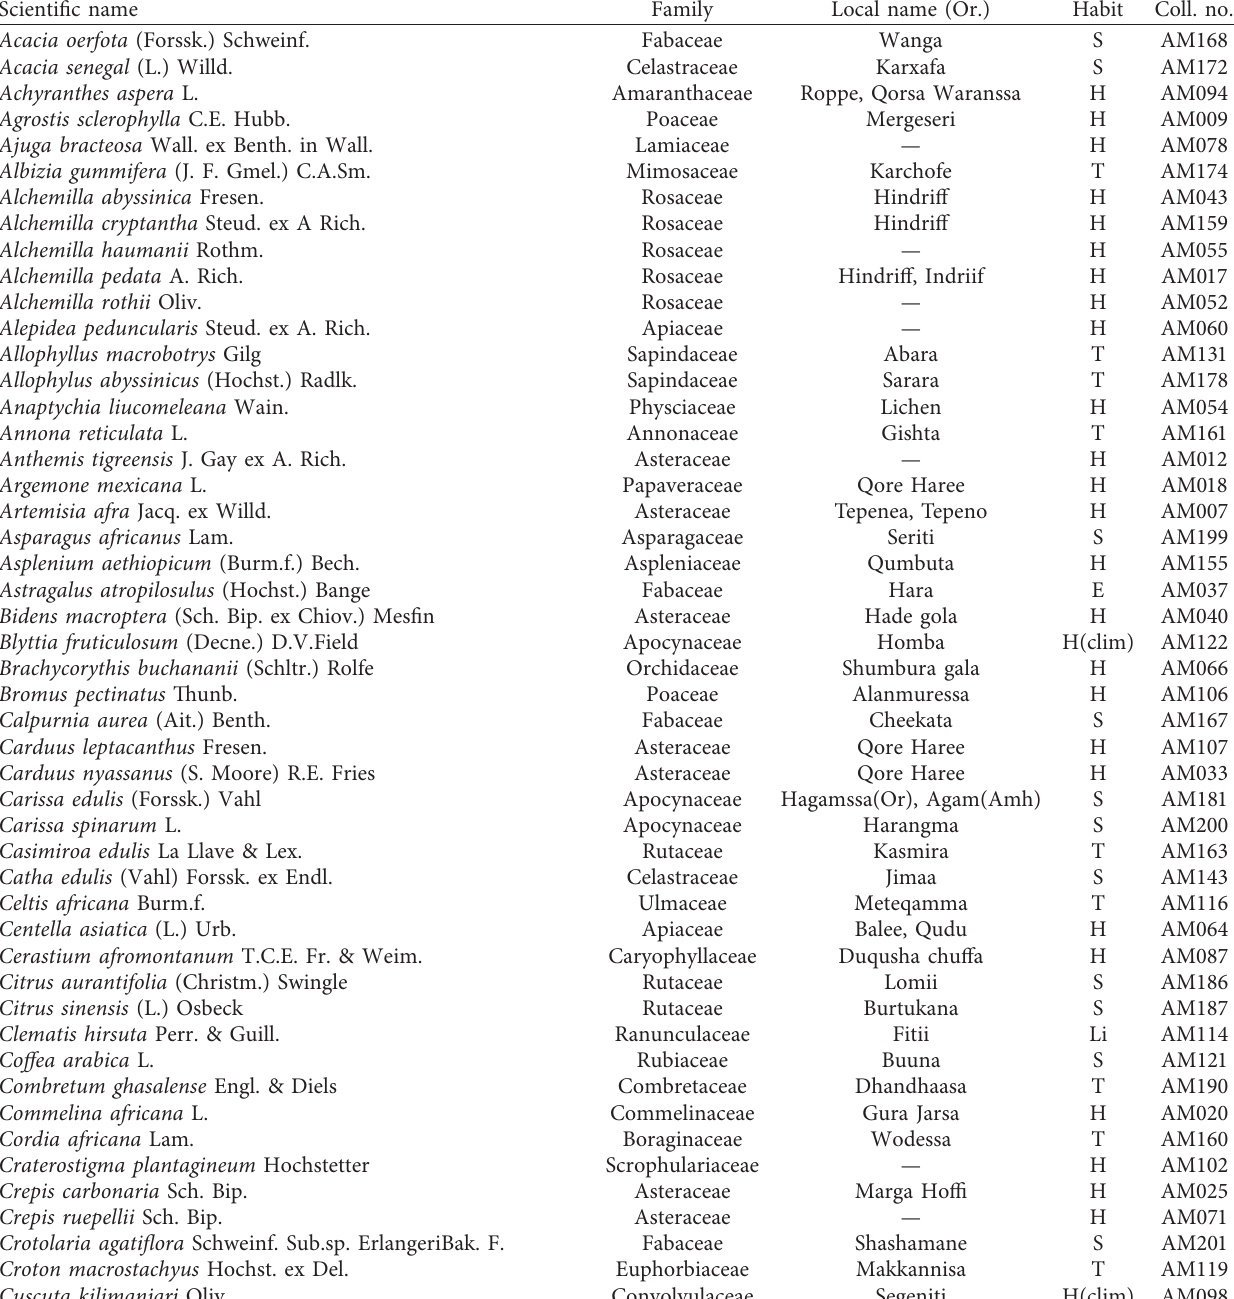
Table 2: List of plant species identified in the